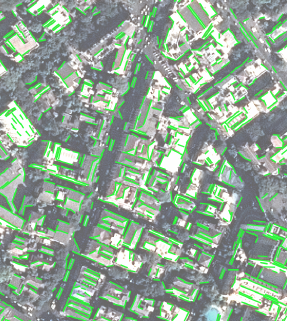
Figure 4. Line segment detected on a PHR image of Bombay